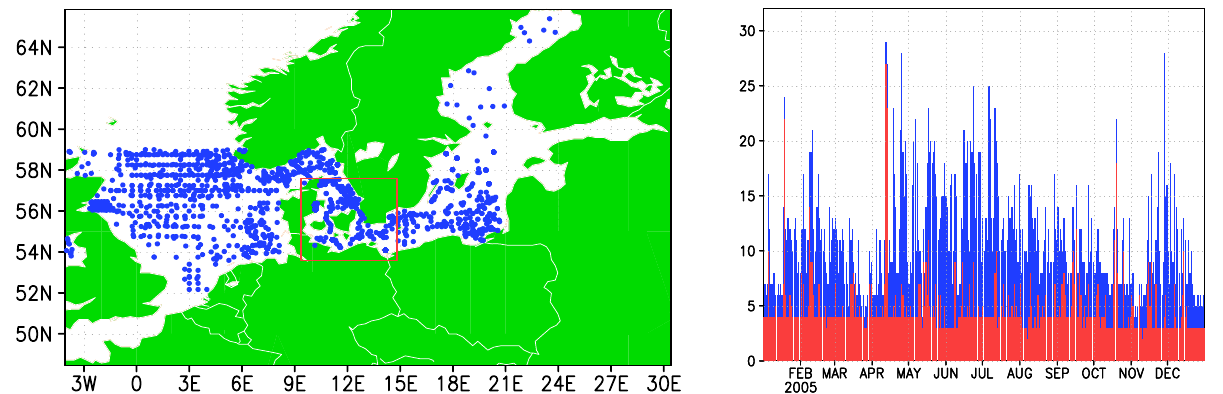
Fig. 2. T/S profile distribution in the North Sea/Baltic Sea during 2005. The upper panel shows the spatial coverage. The outer rectangle frame covers the model coarse grid domain and inner red rectangle frame covers the model fine grid domain. The bottom panel shows the temporal distribution. The blue column indicates the model coarse grid domain, the red column for the model fine grid domain.